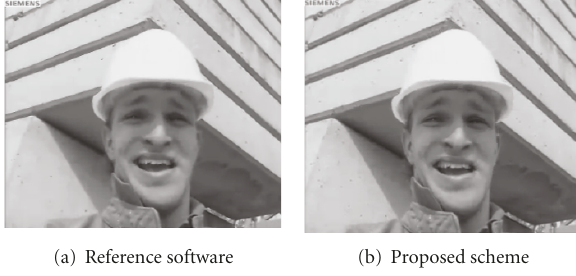
Figure 7: Decoded frames of